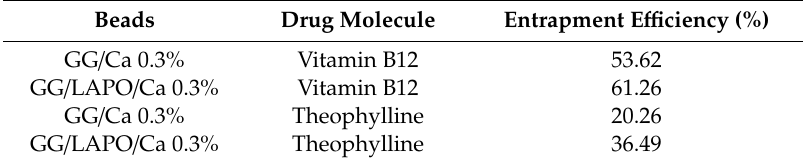
Table 3. Entrapment efficiency of two model drug molecules, theophylline and vitamin B12. Beads